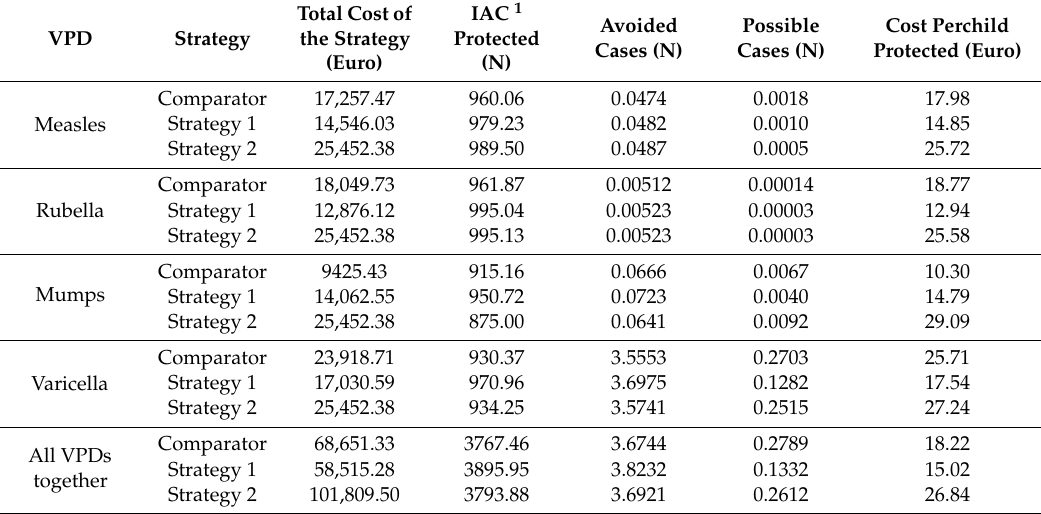
Table A5. Clinical and economic outcomes per 1000 internationally adopted children (IAC) < 1 year of age (CLIA method).